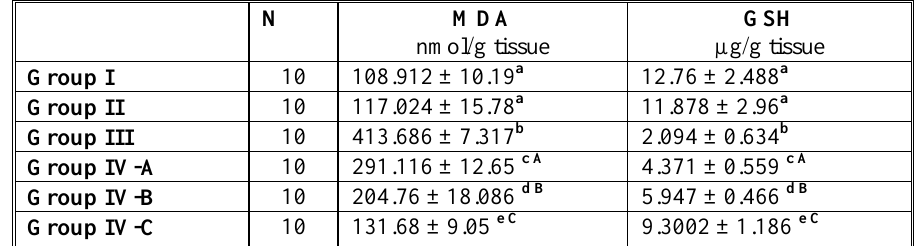
Table (1)The effects of pre-treatment with different doses of pentoxifylline and 100mg.kg -1 pentoxifylline alone on (MDA) contents and reduced glutathione (GSH) levels in rat's liver homogenate compared to CCl and control 4